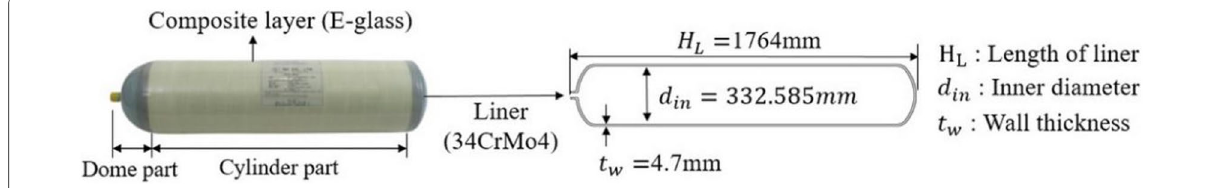
Figure 4 Scheme of liner used for CNG pressure vessel